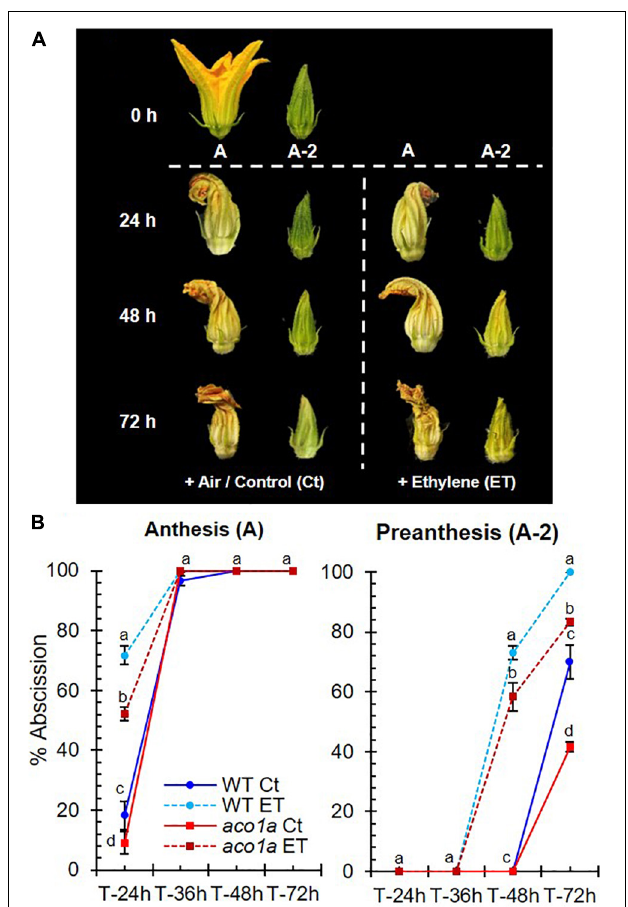
FIGURE 6 | Ethylene sensitivity of WT and aco1a plants. The sensitivity to ethylene was determined by assessing the percentage of flower abscission in response to ethylene in male flowers at two stages of development. (A) Phenotype of male flowers at two stages of development: anthesis (A) and 2 days before anthesis (A-2). Photographs were taken at harvest (0 h of treatment) and 24, 48, and 72 h after the treatment with air or ethylene (ET). (B) Percentage of abscission in male flowers harvested at anthesis (A) or 2 days before anthesis (A-2). Error bars represent SE. Different letters indicate significant differences between flower abscission of each treatment and genotype at the same time after the treatment ( p ≤